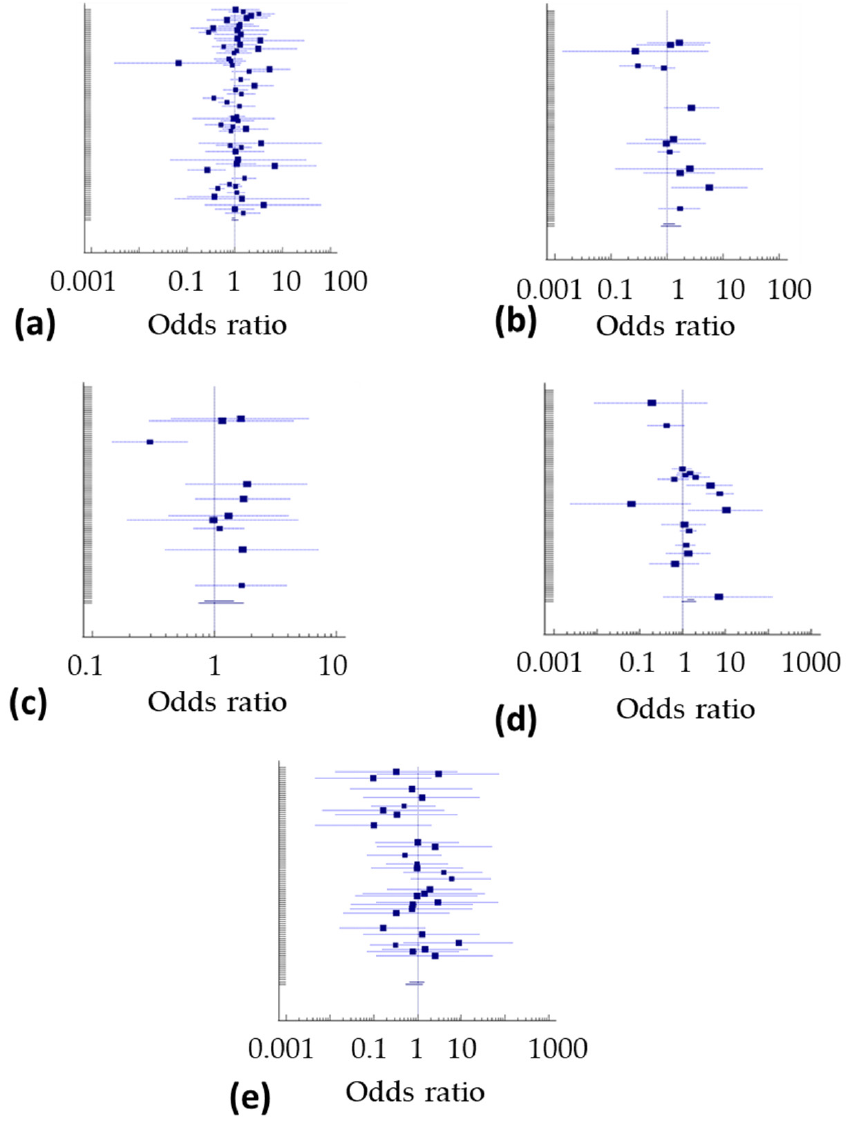
Figure 2. Forest plot summarizing odds ratios for ( a ) nausea; ( b ) hepatobiliary disorders; ( c ) abnormal hepatic functions; ( d ) general disorders and administration site condition; and ( e ) death with AE. The frequencies of these adverse events were not affected by verum medication compared to the placebo medication.